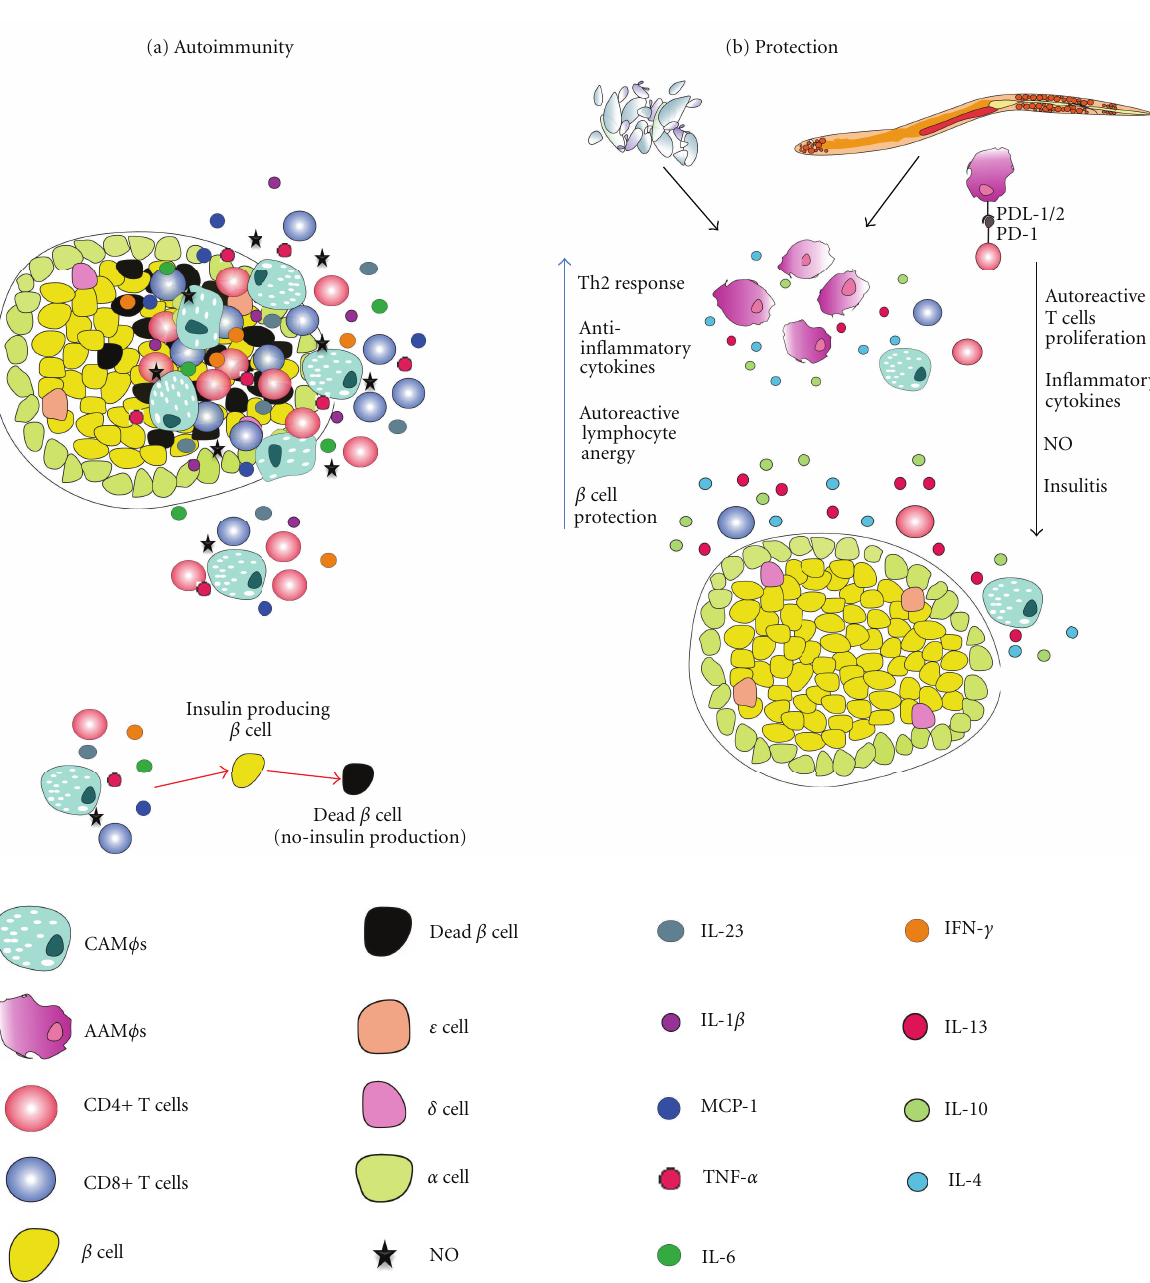
and Th17 cells, together with CD8+ cytotoxic T cells, are considered to be the main cell populations favoring the development of